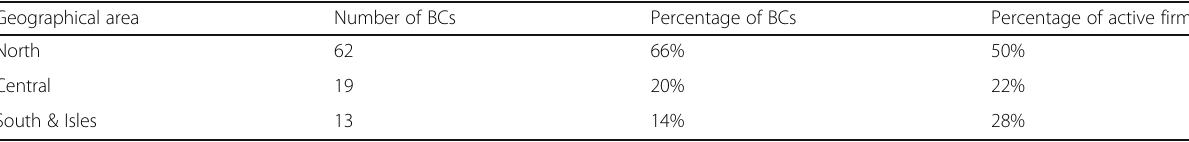
Table 2 Geographical distribution of BCs Geographical